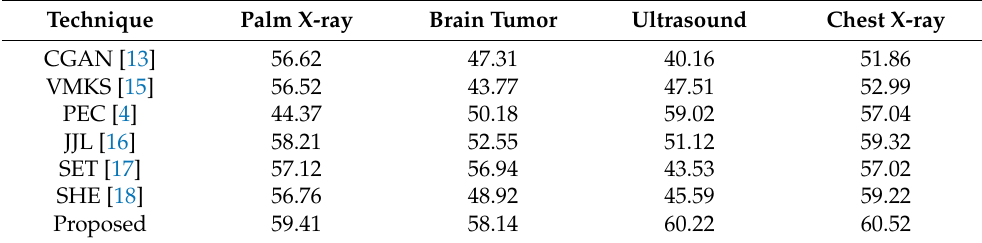
Table 1. Performance evaluation of color images in terms of PSNR between actual and decrypted images.